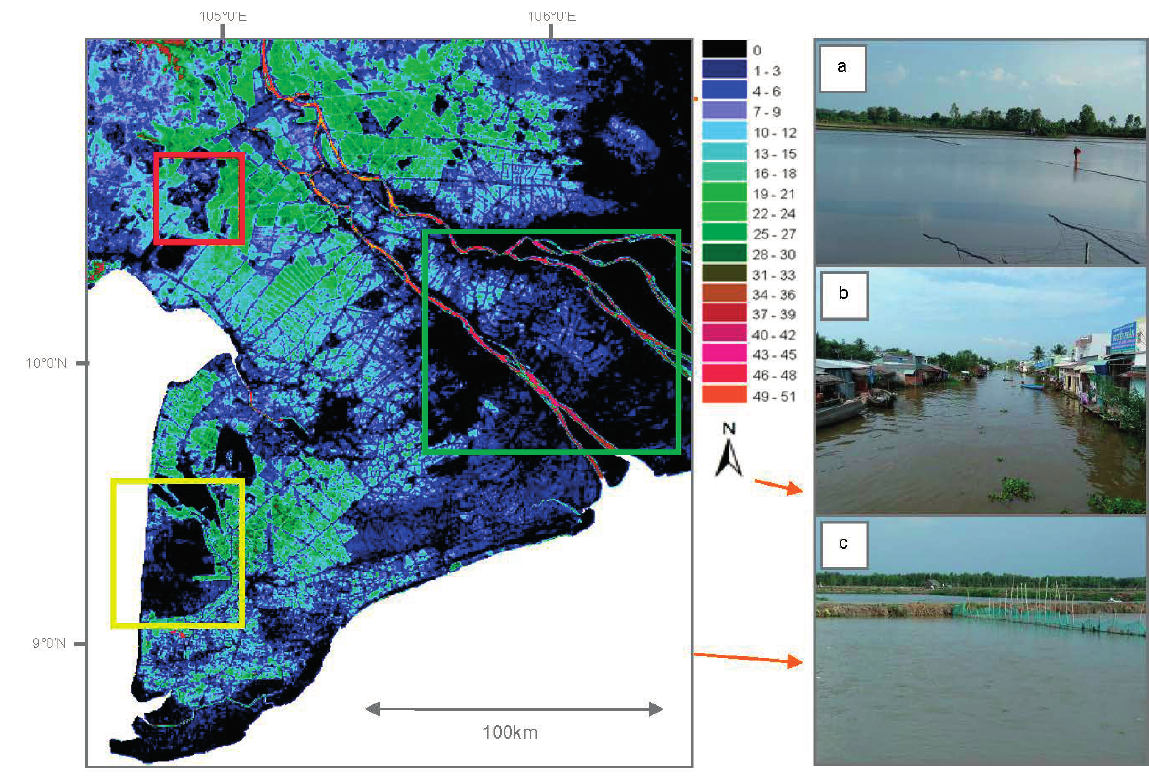
Figure 5. Inundation patterns for the Mekong Delta, as derived from a time series of 150 m resolution ENVISAT ASAR wide swath mode data. An analyses from 51 scenes covering 2007 to 2011 is displayed. Modified based on Kuenzer et al . [15]. ( a ) Overland-flow- related natural irrigation water in the northern area of the delta; ( b ) Narrow canals dissecting the delta; ( c ) inundation at the southwestern tip and coast of the